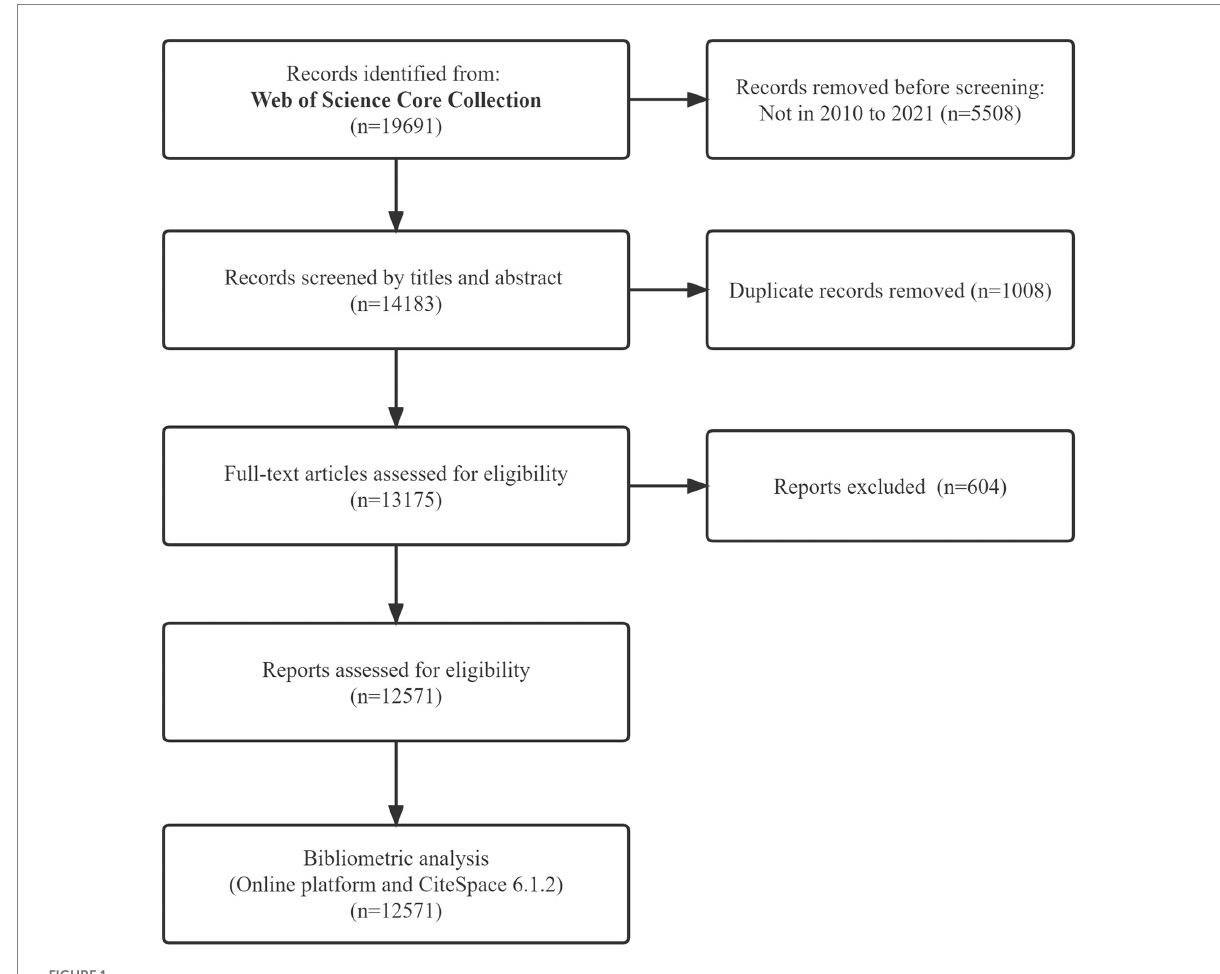
FIGURE 1 The search